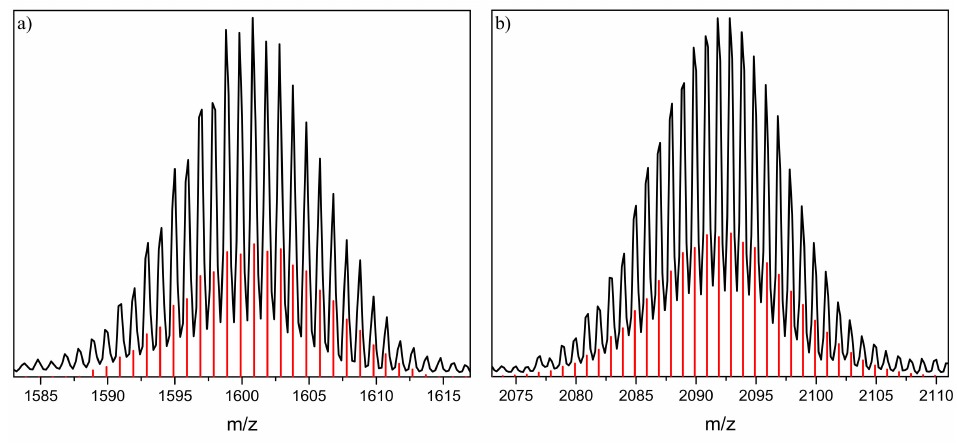
Figure 4. Selected areas of the ESI-MS spectrum obtained by examination of an acetonitrile solution of compound 2 . ( a ) Negative ion mode (4500 V, 300 ◦ C), monitoring 2 with a cleaved [Cu-NHC] + moiety at m / z 1600.8 [NHC Dipp Cu{Ge 9 (Si(TMS) 3 ) 2 }] − and ( b ) positive ion mode (6000 V, 300 ◦ C), monitoring 2 with an attached potassium cation at m / z 2092.8 [(NHC Dipp Cu) 2 {Ge 9 (Si(TMS) 3 ) 2 }K] + . The simulated mass spectra with the corresponding isotope distribution are shown below as red